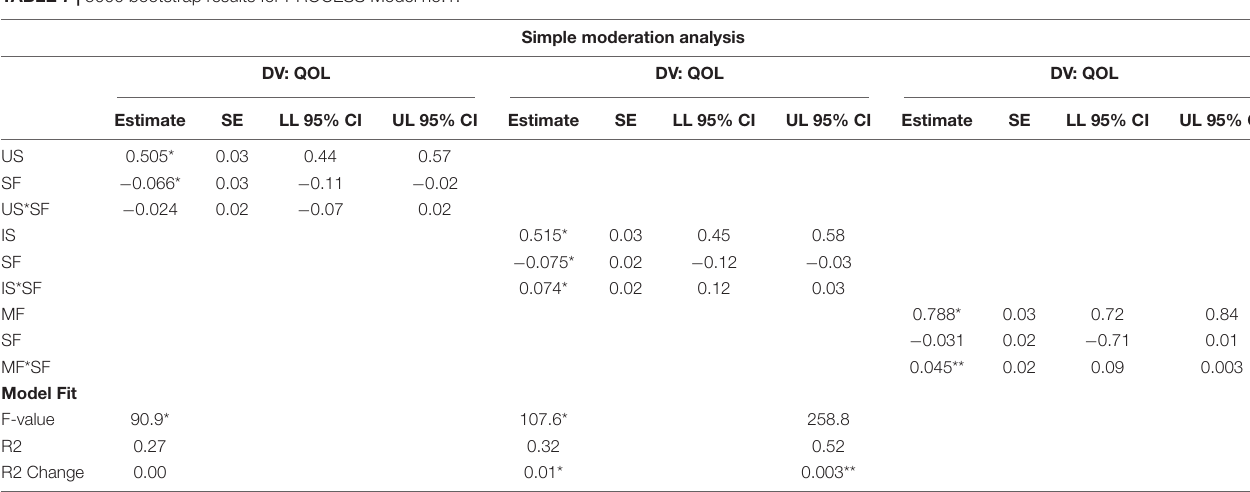
TABLE 7 | 5000 bootstrap results for PROCESS Model